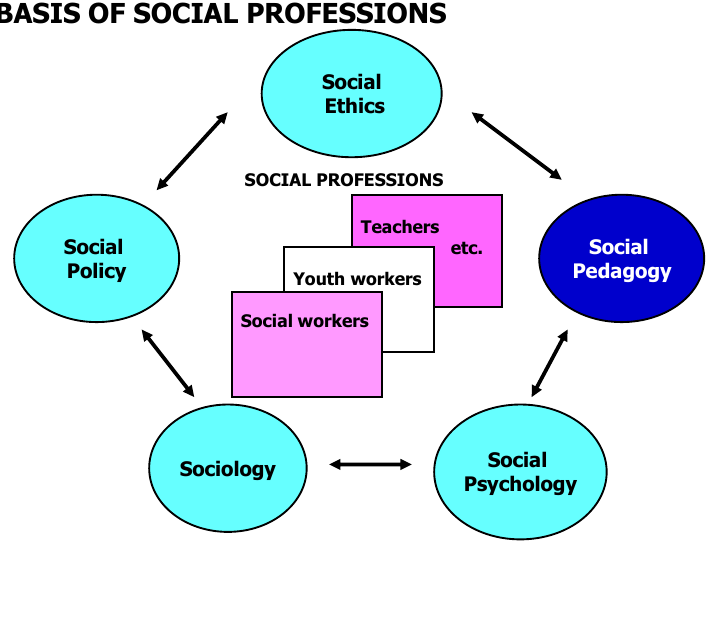
Figure 2. Social pedagogy as a part of the social scientific basis of social